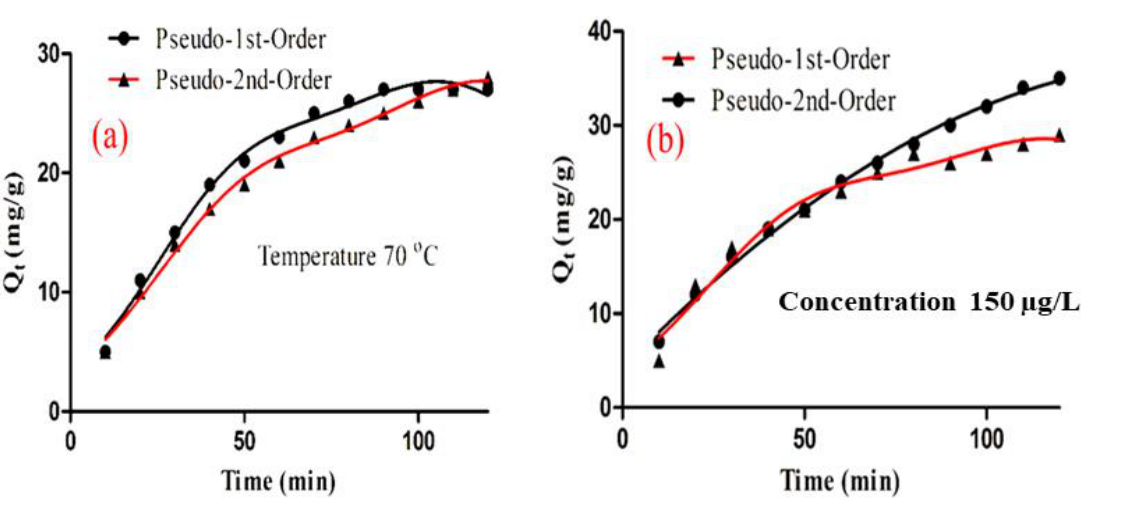
Figure 9. Kinetic study of As(III) removal by ZnO–CuO/g–C 3 N 4 at ( a ) Temperature and ( b ) Concen- tration versus time intervals.